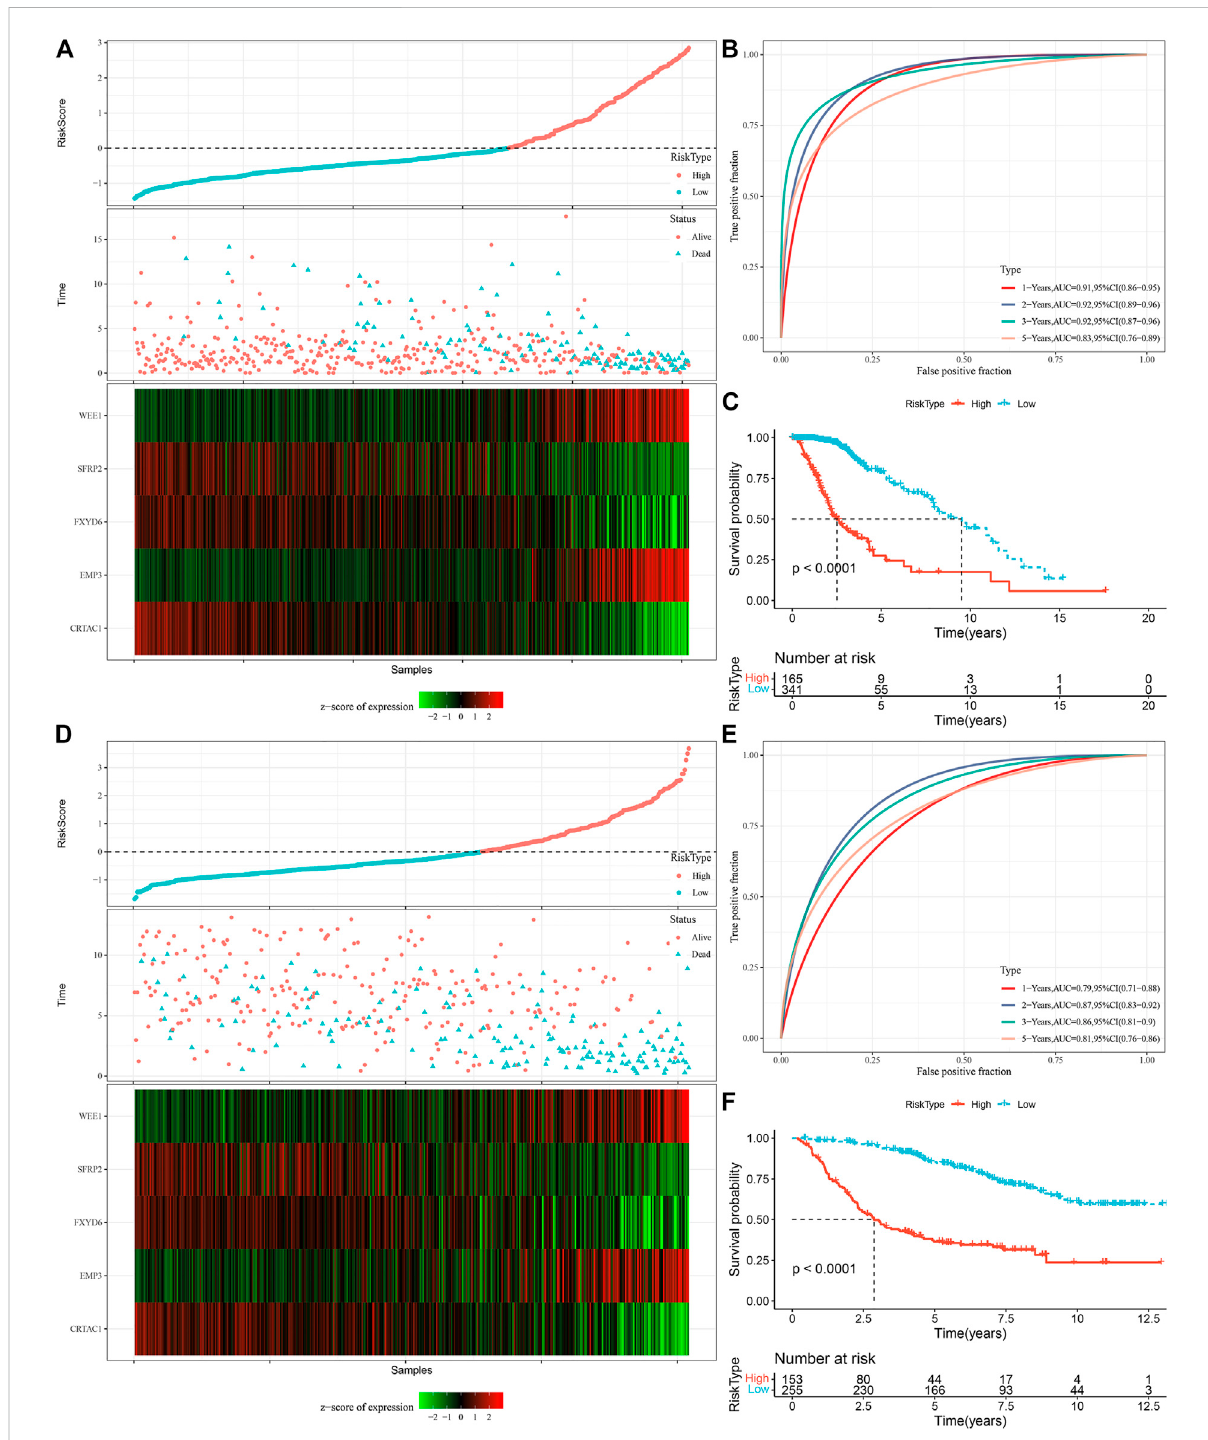
FIGURE 9 Calculation of RiskScore and determination of its robustness in two independent datasets. (A) RiskScore in TCGA dataset, survival time vs. survival status, andexpressionoftheglutamine metabolism-related prognostic genes. (B) ROCcurveofRiskScoreclassi fi cation inTCGA dataset. (C) KMsurvivalcurvesoftworiskgroupsinTCGAdataset. (D) RiskScoreinCCGAdataset,survivaltimevs.survivalstatus,andexpressionoftheglutamine metabolism-related prognostic genes. (E) ROC curve of RiskScore classi fi cation in CCGA dataset. (F) KM survival curves of two risk groups in CGGA